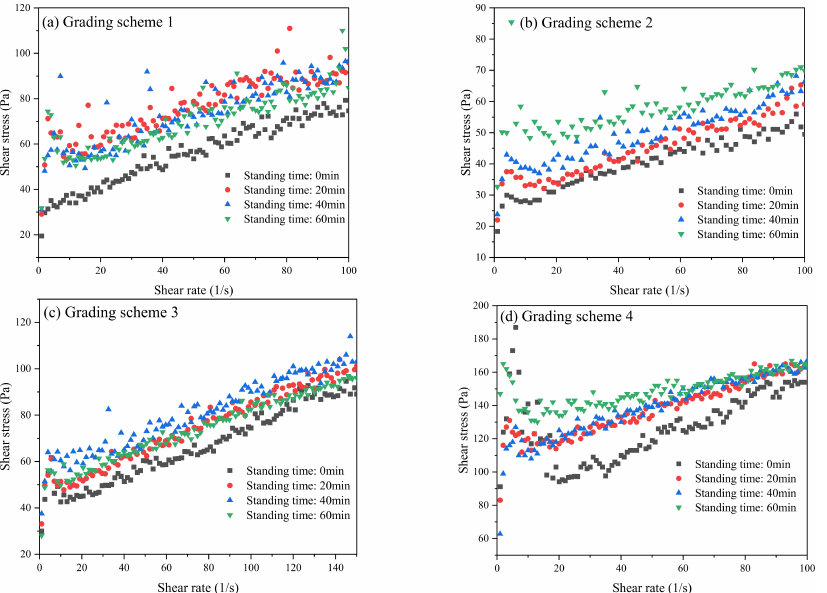
Figure 9. Shear stress & shear rate curve in different grading schemes at 70% mass fraction. ( a ) Grad- ing scheme 1; ( b ) Grading scheme 2; ( c ) Grading scheme 3; ( d ) Grading scheme